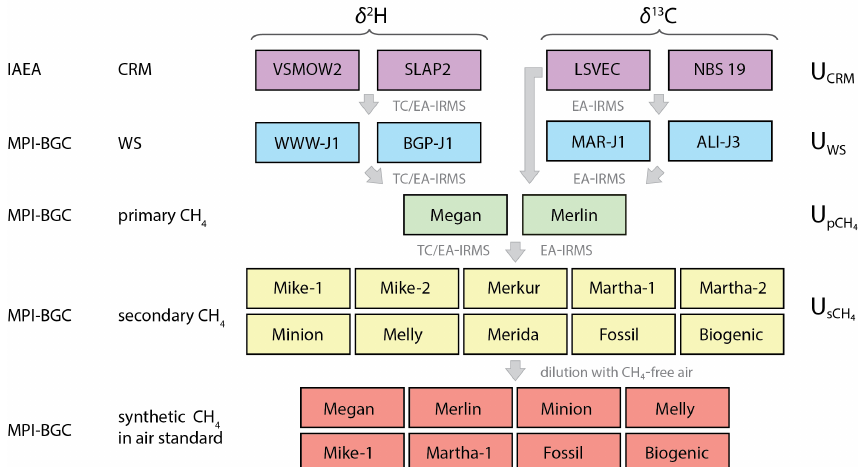
Figure 1. Calibration hierarchy to produce synthetic CH 4 -in-air standards including links of the traceability chain. The long, central arrow shows that the primary CH 4 gases were directly calibrated against CRMs for δ 13 C but not for δ 2 H. The uncertainty ( U ) associated with each calibration hierarchy level is indicated by indices that are described in Sect.